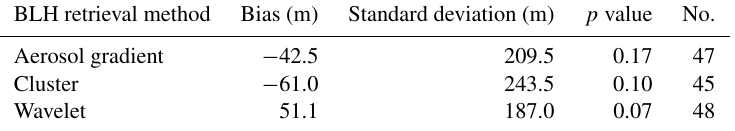
Table 2. Bias, standard deviation, p value, and number of data points (no.) for comparison of BLH retrieval methods to radiosonde BLHs.